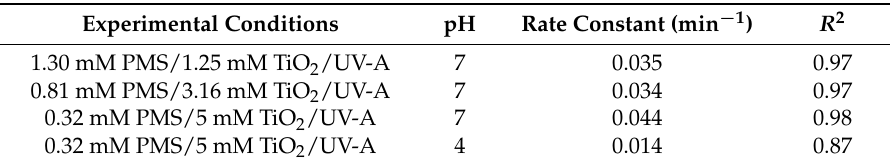
Figure 5. Influence of the PMS:TiO 2 ratio (1.04:1; 0.26:1; 0.064:1) and pH (4 and 7) in MB discolouration through PMS photocatalytic activation with TiO 2 and UV-A radiation. Table 3. First-order kinetic rates (min − 1 ) for the photocatalytic activation of PMS with TiO 2 under different operating conditions.